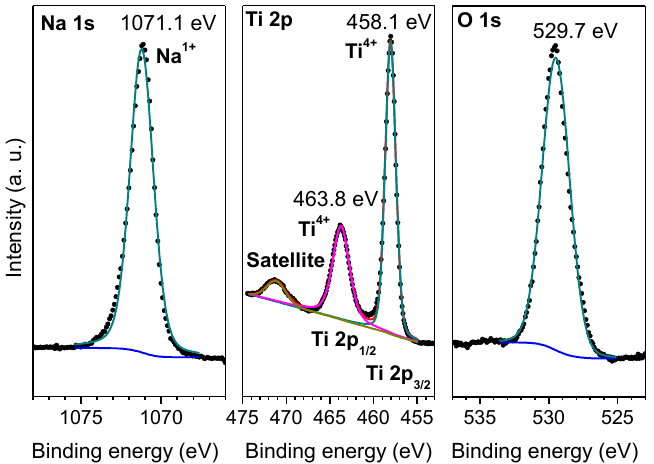
Figure 2. XPS spectra of Na 1s, Ti 2p, and O 1s in the NTO sample.